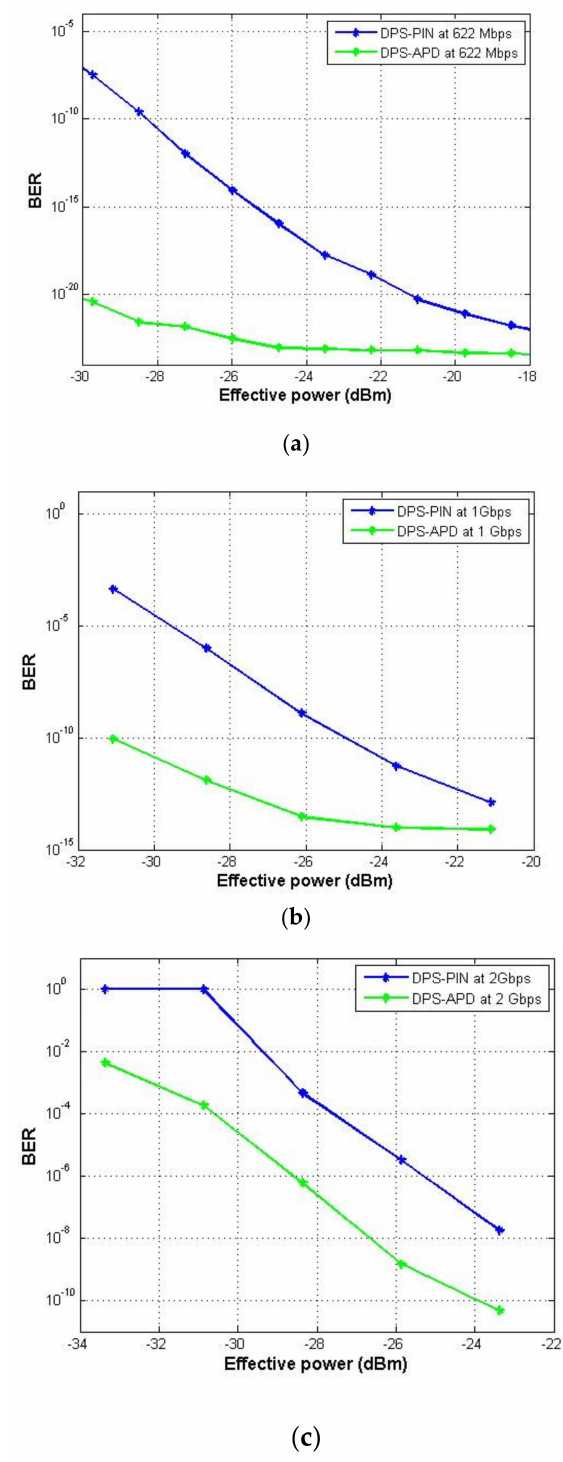
Figure 13. BER versus received power at ( a ) 622 Mbps, ( b ) 1 Gbps, and ( c ) 2